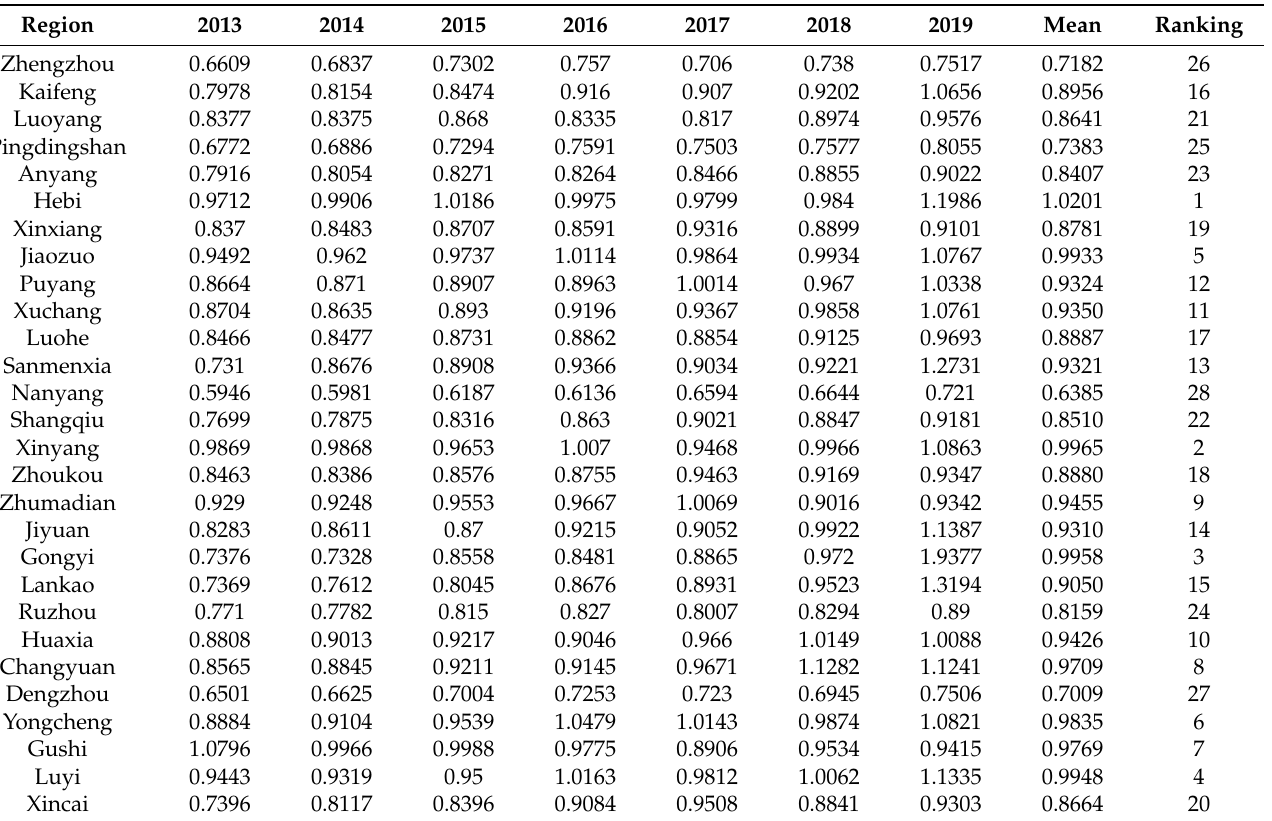
Table 4. Efficiency of the agricultural circular economy in various cities (counties) of Henan Province in 2013–2019 under the super-efficiency DEA